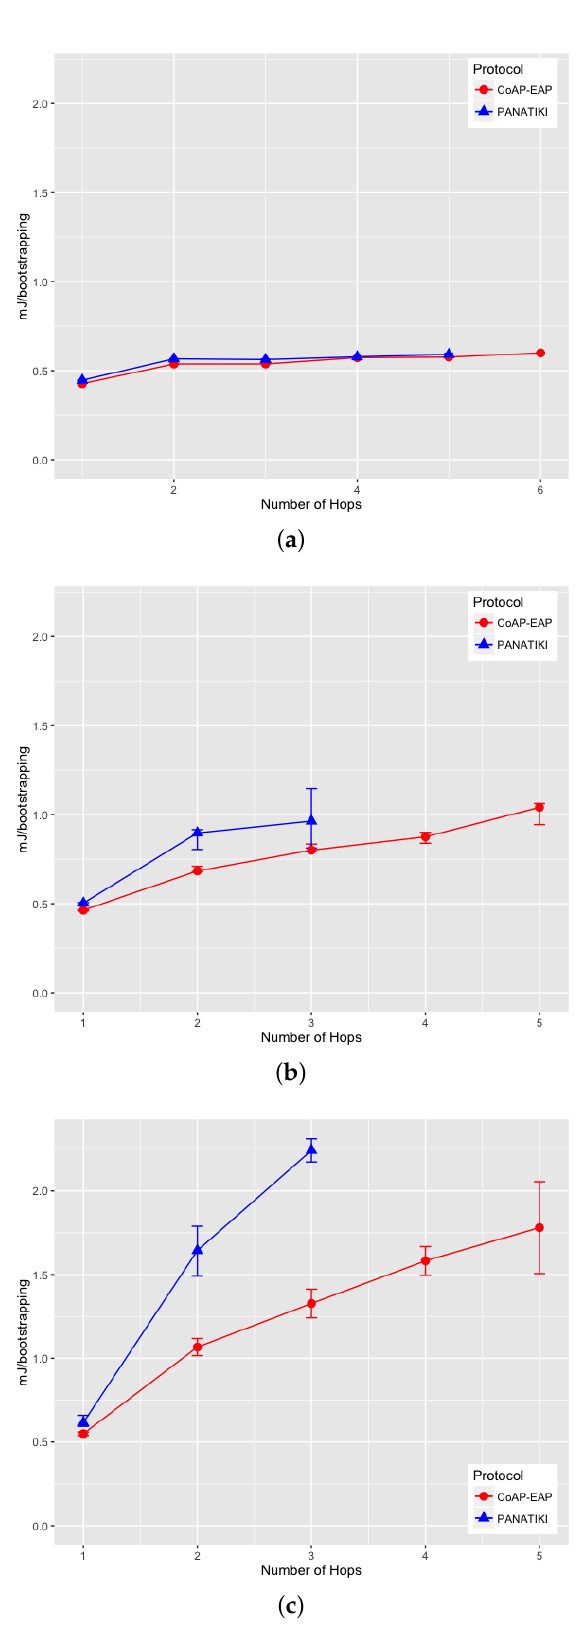
Figure 12. CPU energy consumption. ( a ) CPU energy consumption with 0.0 loss ratio; ( b ) CPU energy consumption with 0.1 loss ratio; ( c ) CPU energy consumption with 0.2 loss